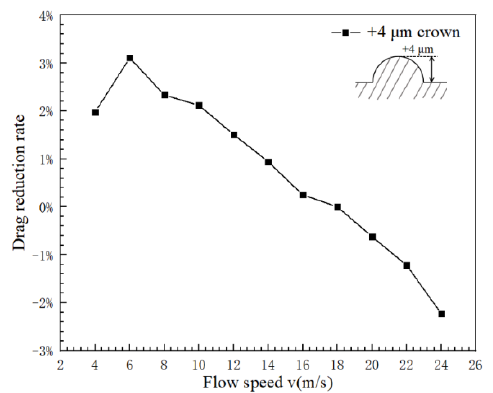
Figure 4. Relationship between surface drag reduction rate and velocity of hemispherical positive coronary